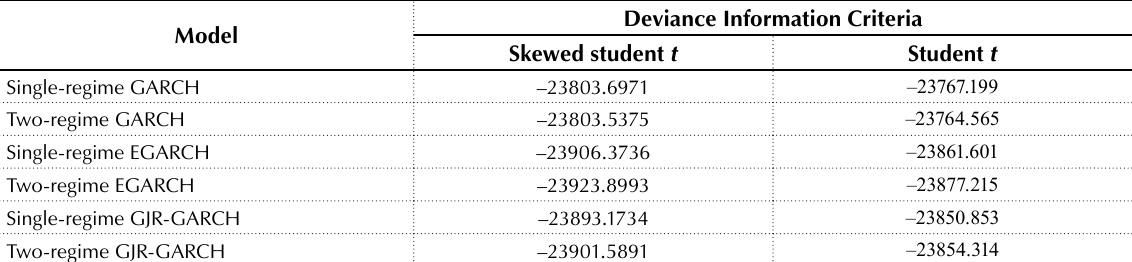
Table 2. Deviance Information Criteria of the models